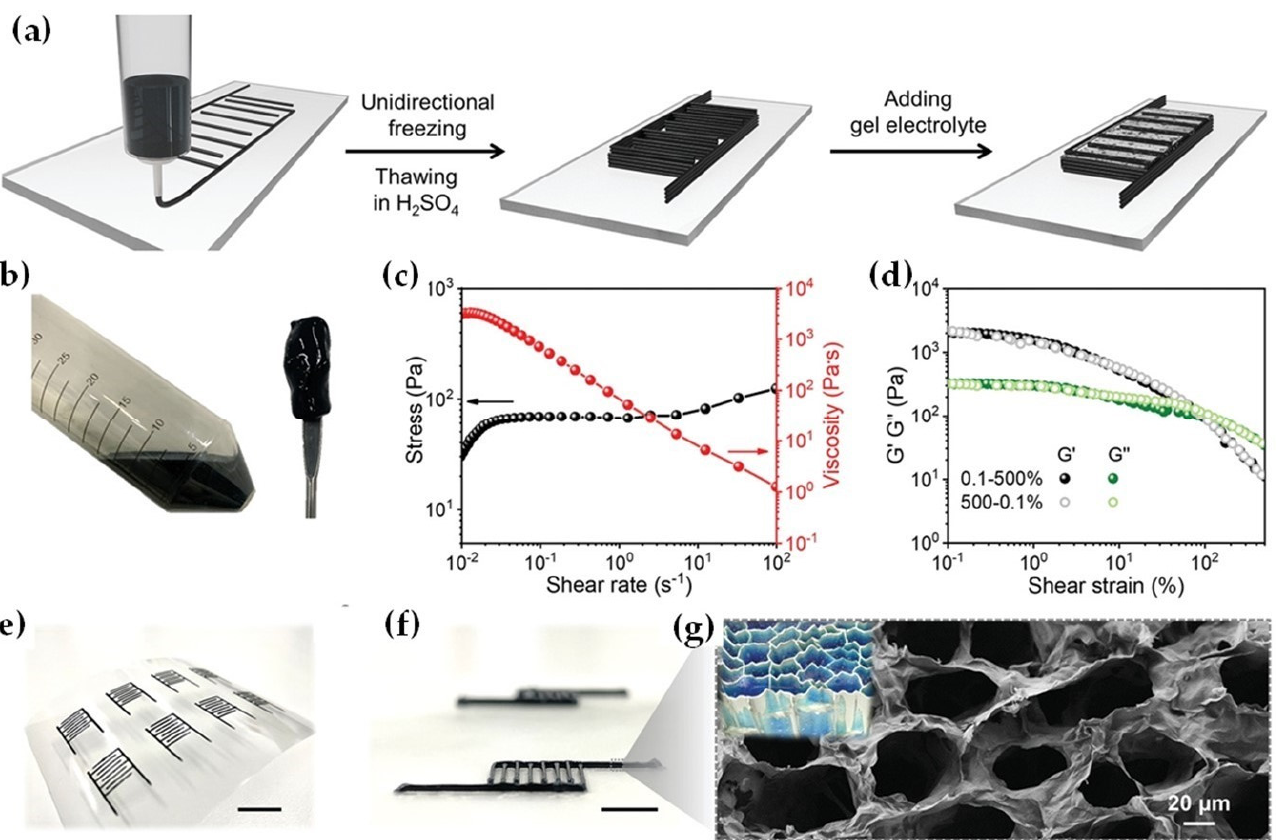
Figure 11. ( a ) The fabrication process of 3D-printing all-MXene MSC via MSES. ( b ) The digital photographs of MXene slurry. ( c ) Shear-thinning behavior of the MXene inks (stress and viscosity against different shear rates). ( d ) The oscillatory measurements (1 Hz) of the MXene ink, which sweeps from 0.1% to 500% and back to 0.1% strain. ( e , f ) Photographs of 3D-printed MXene MSC, scale bar is 1 cm. ( g ) The top-view SEM image of MXene hydrogel MSC, reprinted with permission from